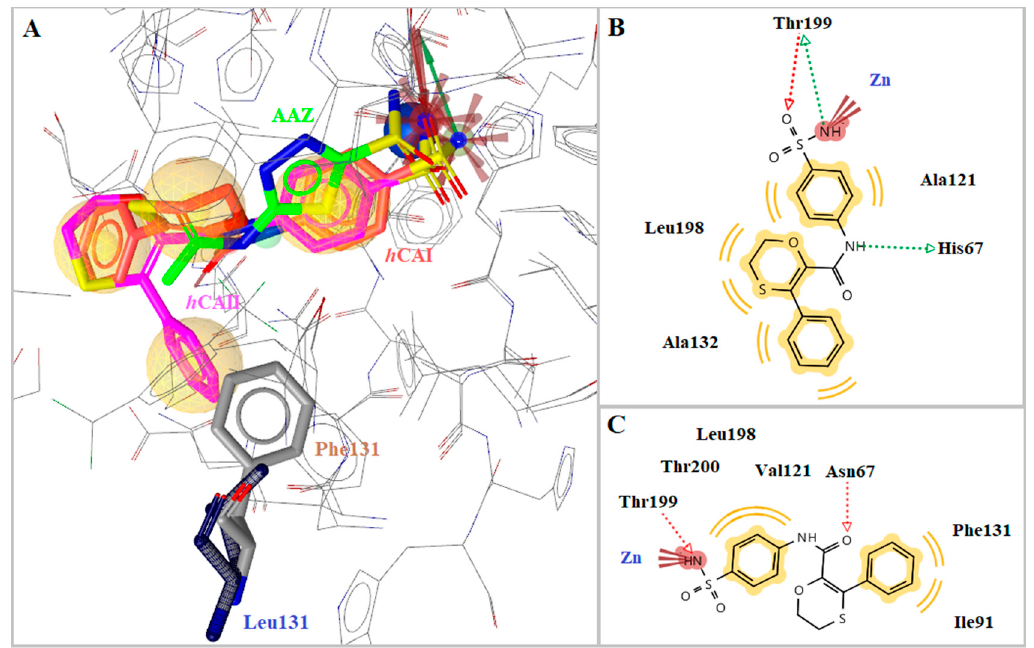
Figure 5. ( A ) Superposition of compound 14a bound to hCA I (orange) in comparison to hCA II (magenta) and AAZ (green) in hCA I, ( B ) 2D interaction diagram of compound 14a docking pose interactions with the key amino acids in hCA I, ( C ) in hCA II. Active site zinc is shown as a blue sphere, red dotted and green arrows indicate H-bond and yellow spheres hydrophobic interactions.